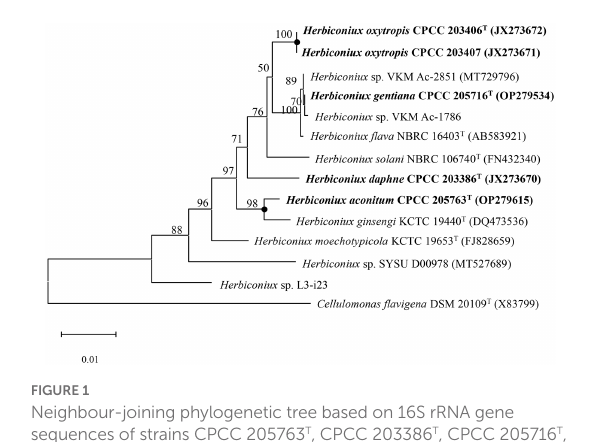
FIGURE 1 Neighbour-joining phylogenetic tree based on 16S rRNA gene sequences of strains CPCC 205763 T , CPCC 203386 T , CPCC 205716 T , CPCC 203406 T , CPCC 203407, and related species of the genus Herbiconiux . Filled circles indicate that the corresponding nodes were also recovered in the trees generated with the maximum- likelihood and maximum-parsimony methods. Bootstrap values (those above 50%) are shown as percentages of 1,000 replicates. Cellulomonas flavigena DSM 20109 T (GenBank accession no. X83799) was used as an outgroup. Bar, 0.01 nt substitution per